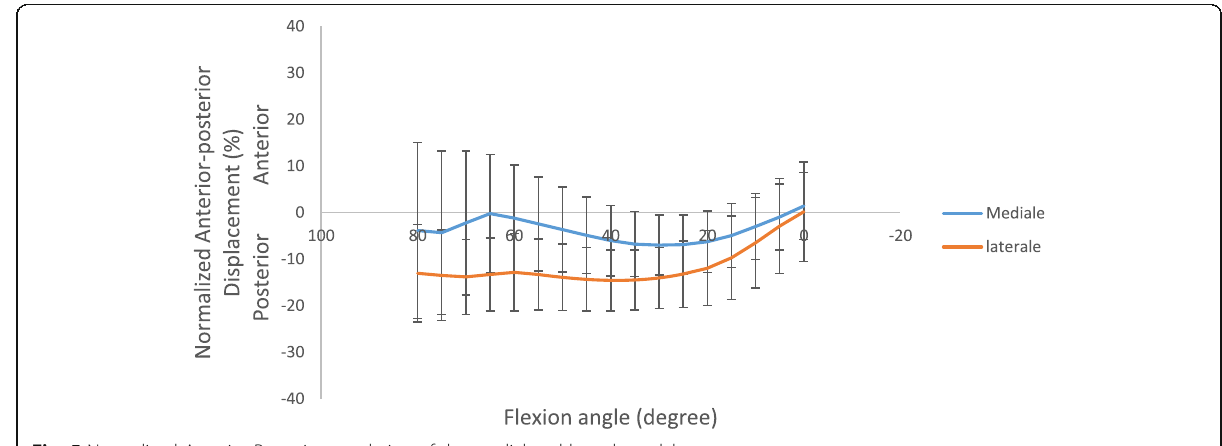
Fig. 5 Normalized Anterior-Posterior translation of the medial and lateral condyles